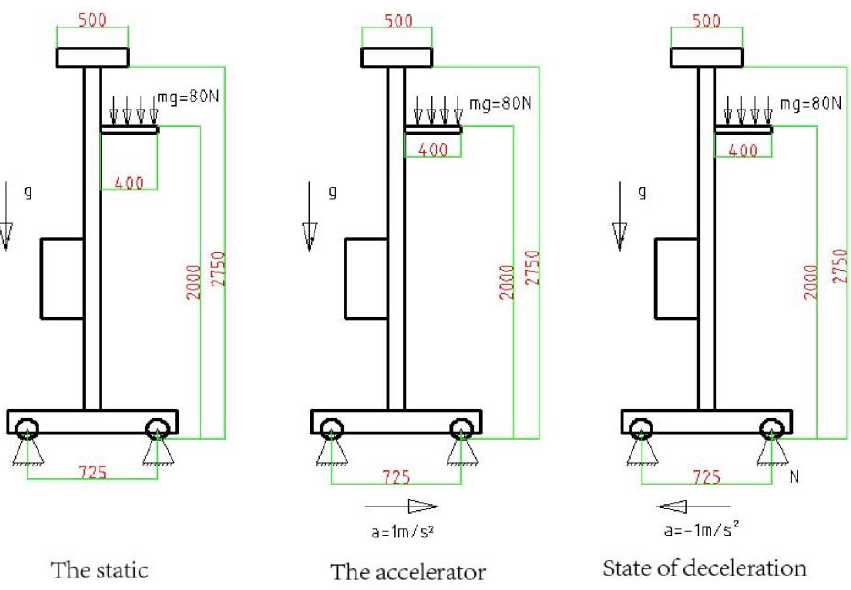
Figure 1. A working condition analysis of small rail roadway stacker.